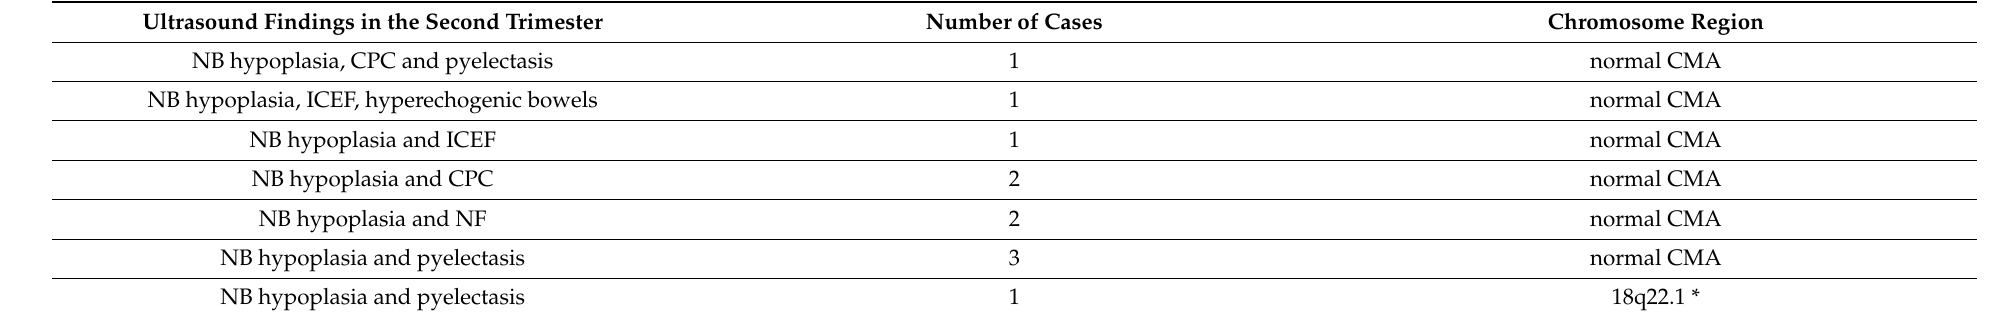
Table 2. Cases with nasal bone hypoplasia and soft